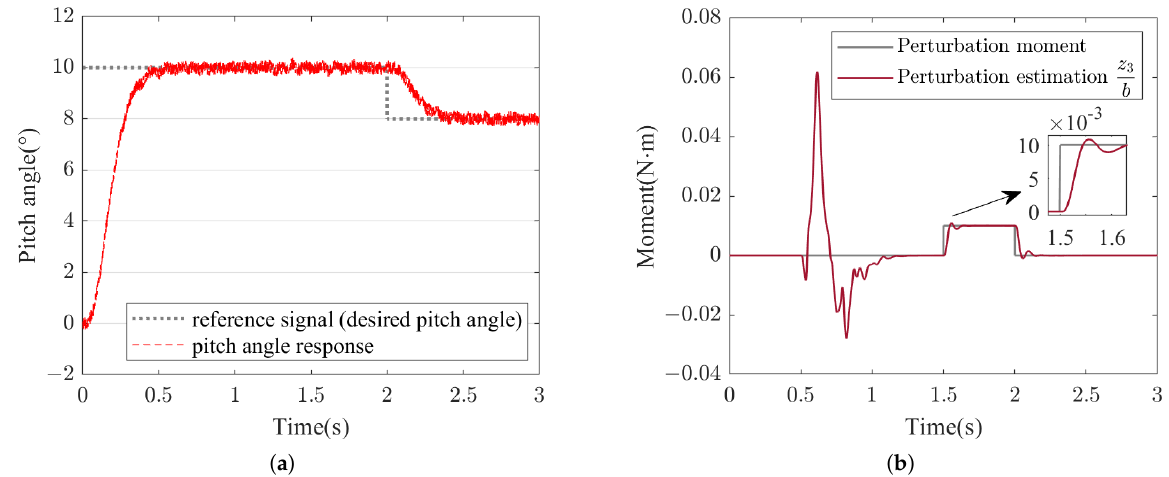
Figure 5. System simulation in normal state with internal and external disturbances. ( a ) Pitch angle response of the simulation model in normal state. ( b ) LESO external disturbance estimation results.